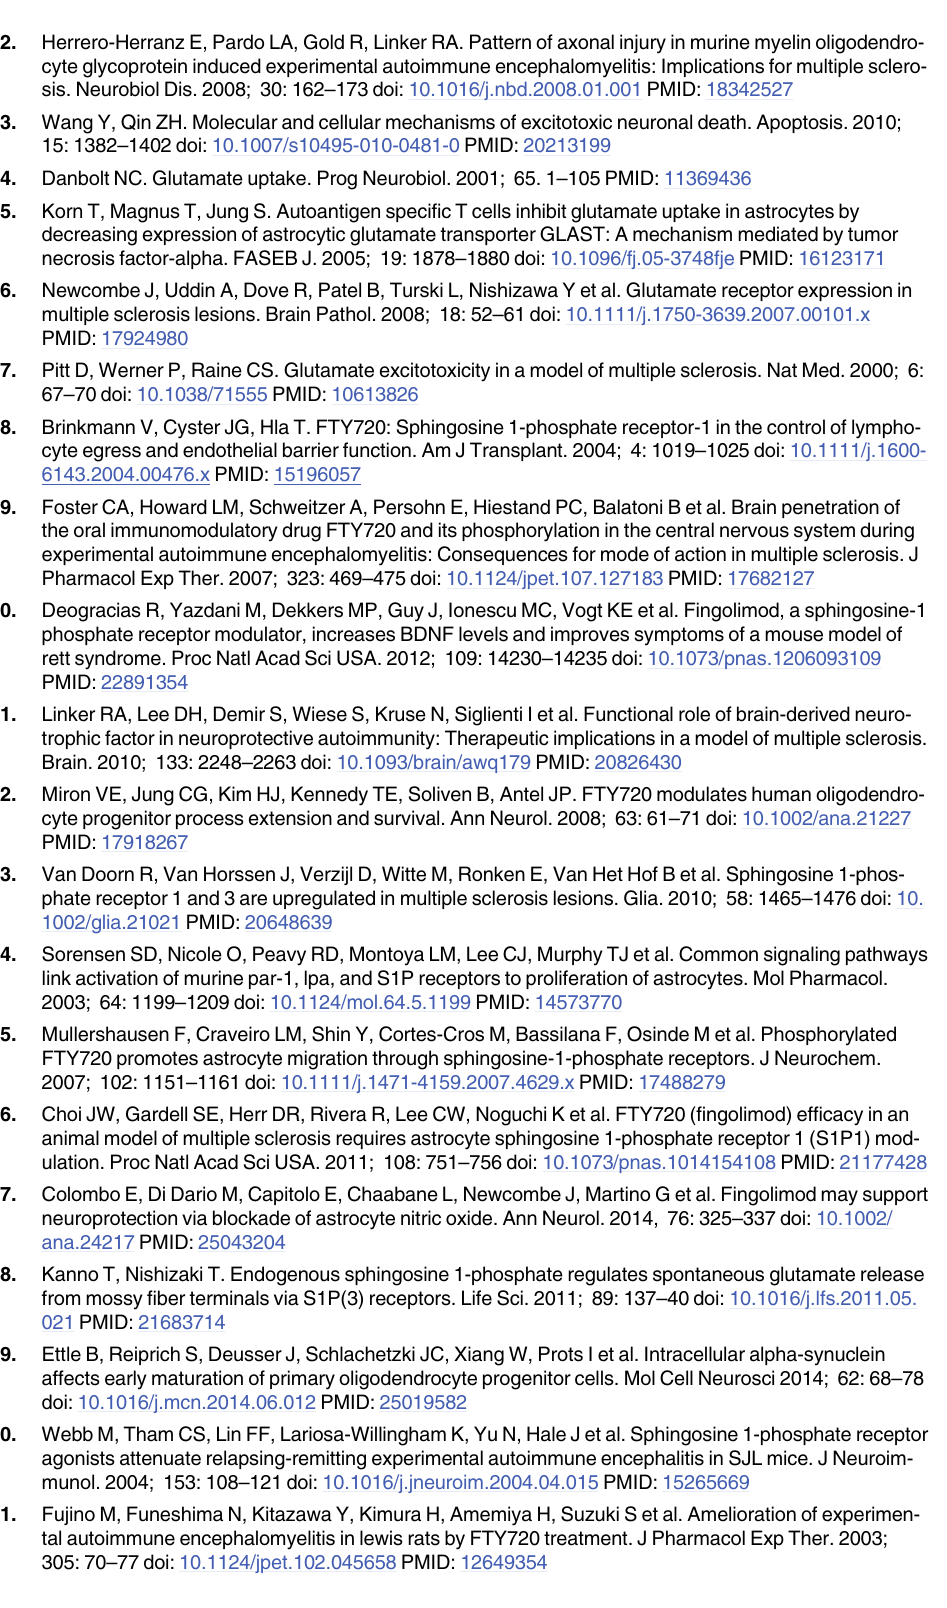
PLOS ONE | DOI:10.1371/journal.pone.0171552 March 8,